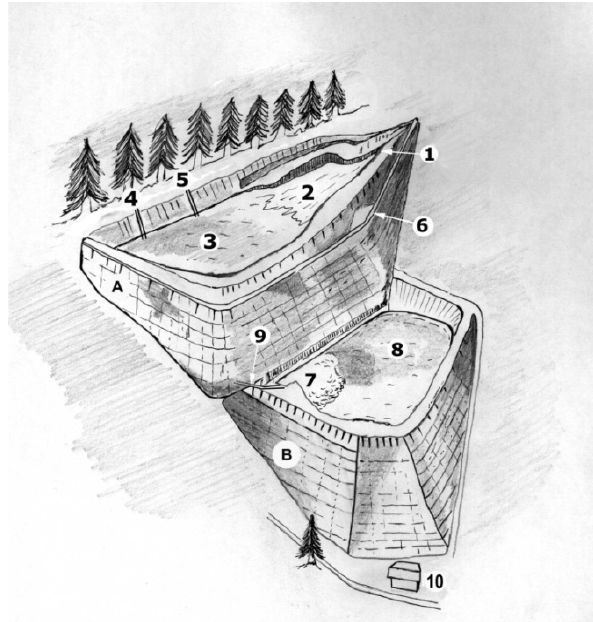
Fig. 3 – 1981 ‐ 82: bottom view of the two